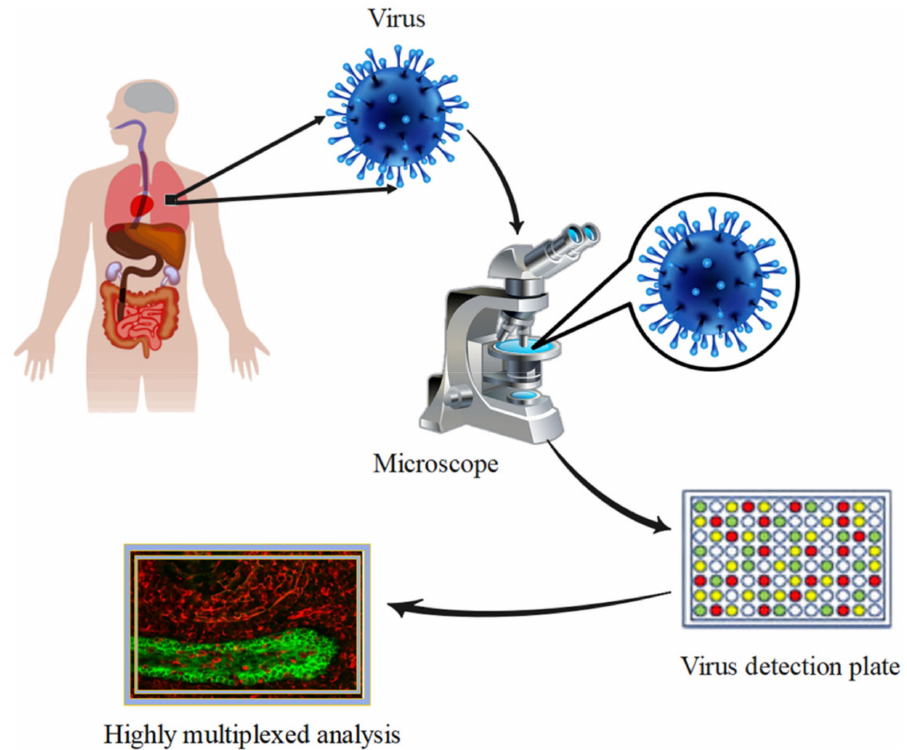
Figure 5. Highly multiplexed analysis for viral